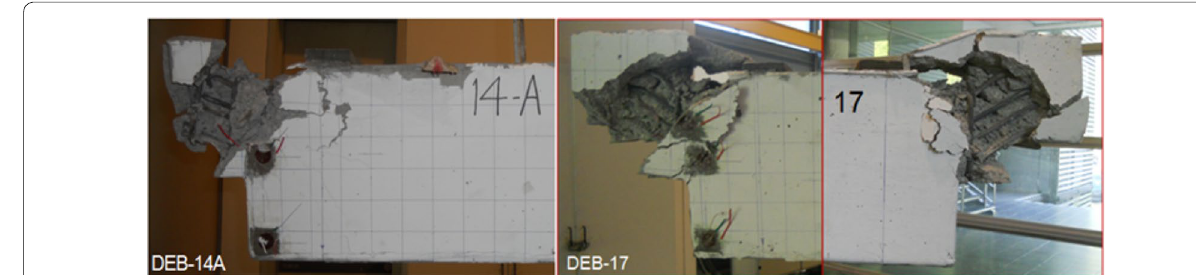
Fig. 18 The beams condition after testing (For DEB-14A and DEB-17).